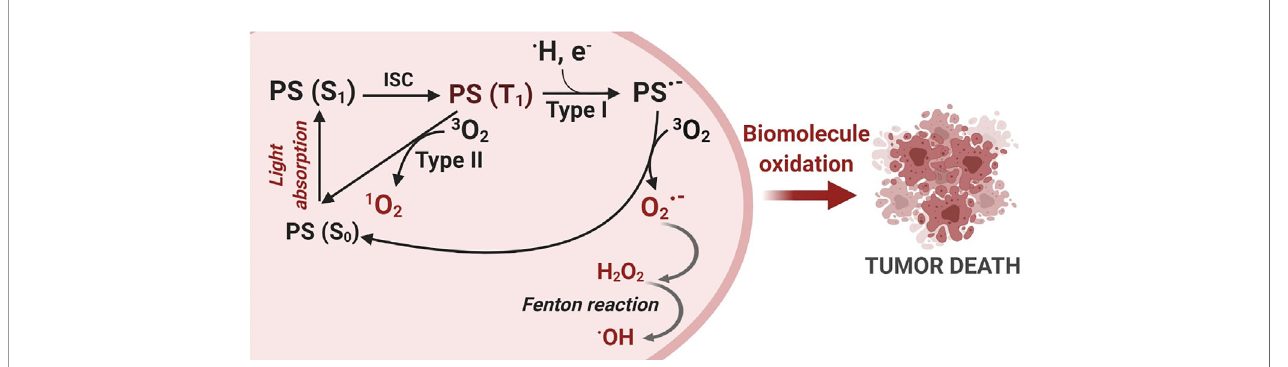
FIGURE 1 | Photodynamic Therapy Mechanism. The photosensitization process starts with a photon absorption that converts the photosensitizer PS (S 0 ) ground state to a more energetic state known as a singlet excited state PS (S 1 ). Then, an intersystem crossing conversion (ISC) changes the PS multiplicity to a triplet excited state PS (T 1 ). PS (T 1 ) can interact with molecules nearby and react via two distinct mechanisms: Type I – electron transfer and Type II – energy transfer, generating reactive oxygen species (ROS). Finally, oxidative species damage biomolecules and can trigger cell death. Created